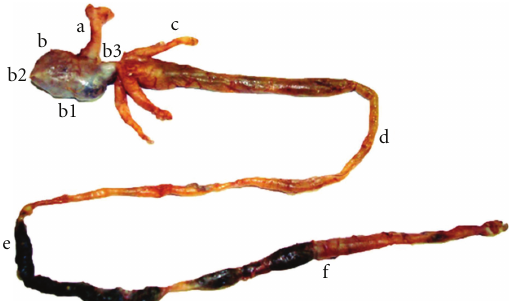
Figure 2: Structures of the digestive tract of S. fuscus : (a) esophagus, (b) stomach, (b1) cardiac stomach, (b2) fundic stomach, (b3) pylo- ric stomach, (c) pyloric caeca, (d) anterior intestine, (e) midintes- tine, and (f) posterior